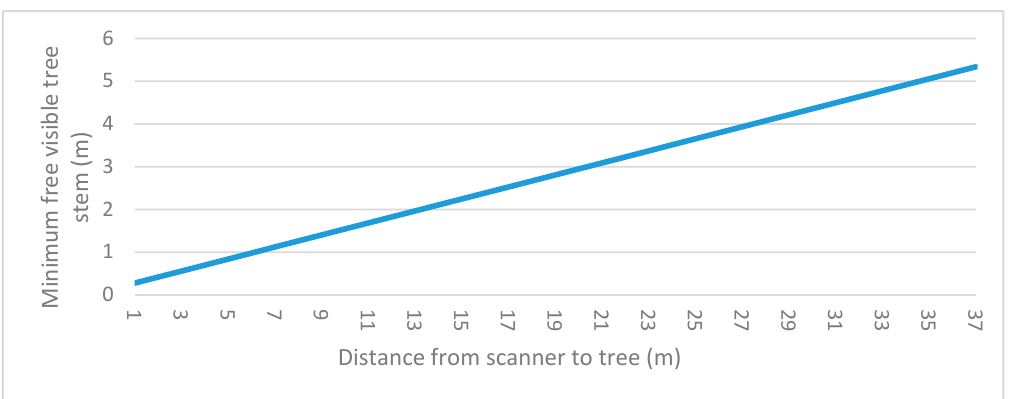
Figure 8. Calculated minimum unobstructed view to the tree stem based on observed distance. The calculation is based on Equation (2).